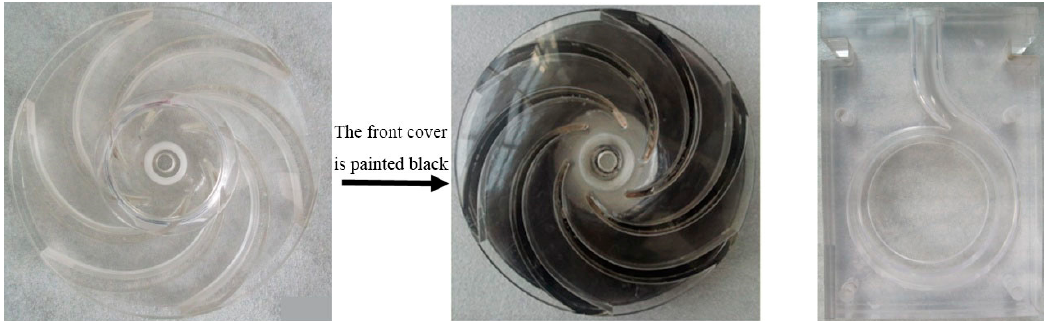
Figure 18. Distribution of turbulent kinetic energy under design condition with different tongue angles.